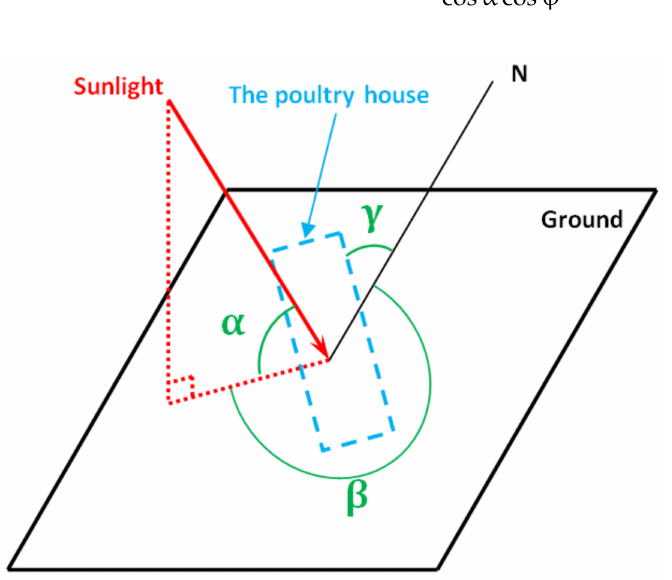
Figure 7. Schematic drawing of the solar elevation angle, α , and solar azimuth angle, β